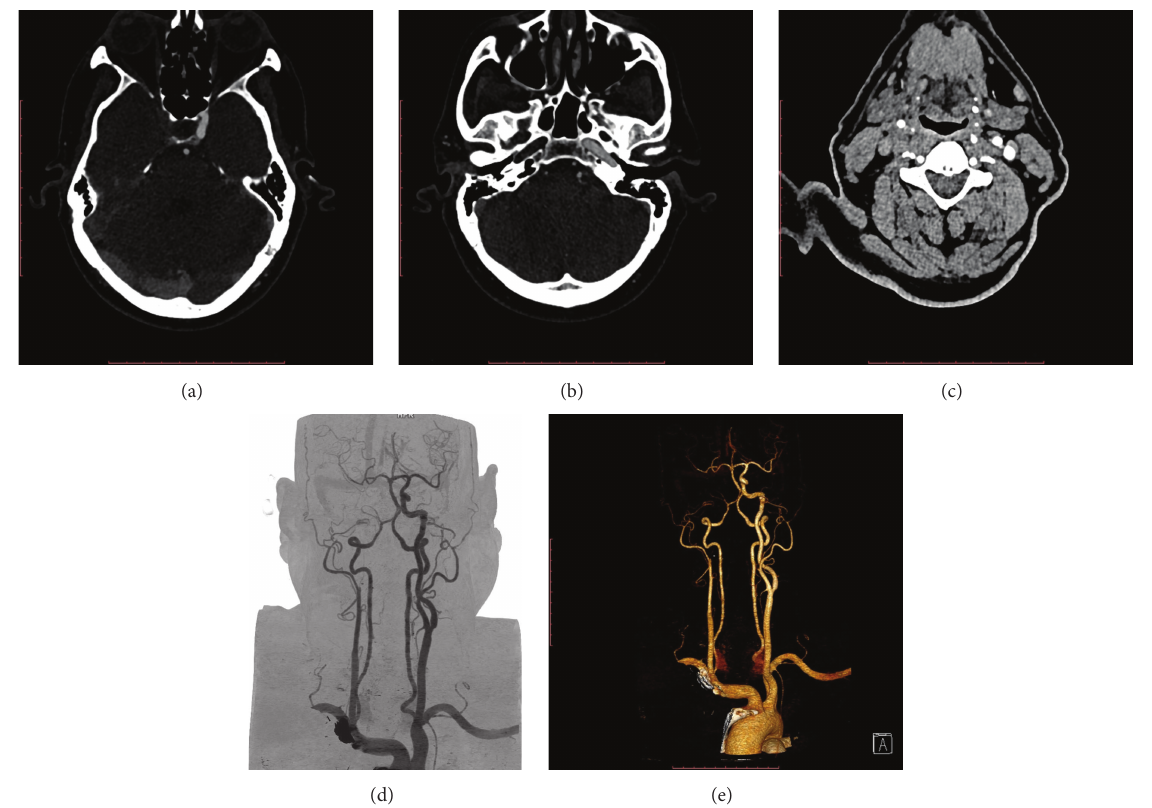
Figure 3: (a) Computed tomographic angiography axial image of the patient shows nonvisualization of the right internal carotid artery. (b) Computed tomographic angiography axial image of the patient shows nonvisualization of the right internal carotid artery with normal right carotid canal. (c) Computed tomographic angiography axial image of the patient at caudal level shows nonvisualization of the right internal carotid artery. Normal internal and external carotid arteries are seen on contralateral side. (d) Digital subtraction angiographic image reconstructed by the volumetric rendering techniques shows absent right internal carotid artery with right middle cerebral artery being supplied by the collateral circulation through the anterior cerebral artery and anterior communicating arteries. (e) Three-dimensional reconstruction by the volumetric rendering techniques shows absent right internal carotid artery with right middle cerebral artery being supplied by the collateral circulation through the anterior cerebral artery and anterior communicating